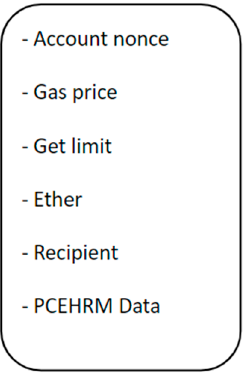
Figure 4. The data structure of the blockchain ledger of PCEHRM.